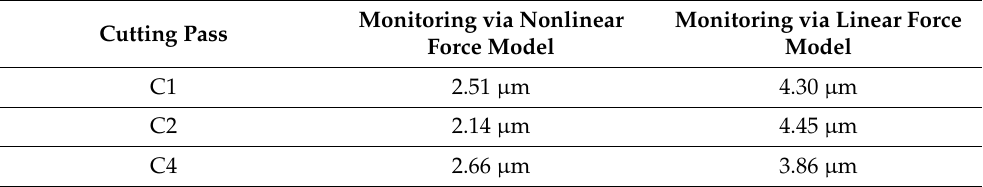
Table 8. The average tool wear monitoring